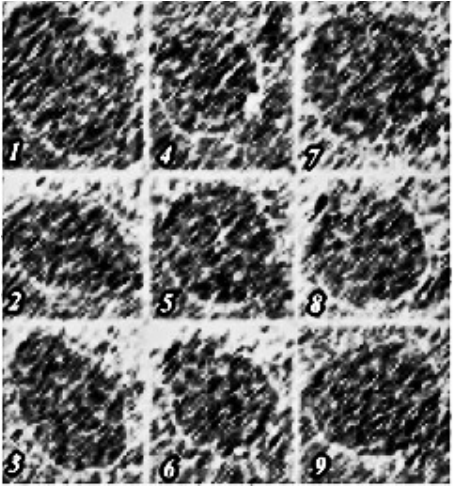
Figure 6. Processing the image of potato tubers in Figure 2 by the HOG method: ( 1 – 3 ) dry rotted tubers; ( 4 – 6 ) tubers affected by rodents; ( 7 – 9 ) healthy tubers.